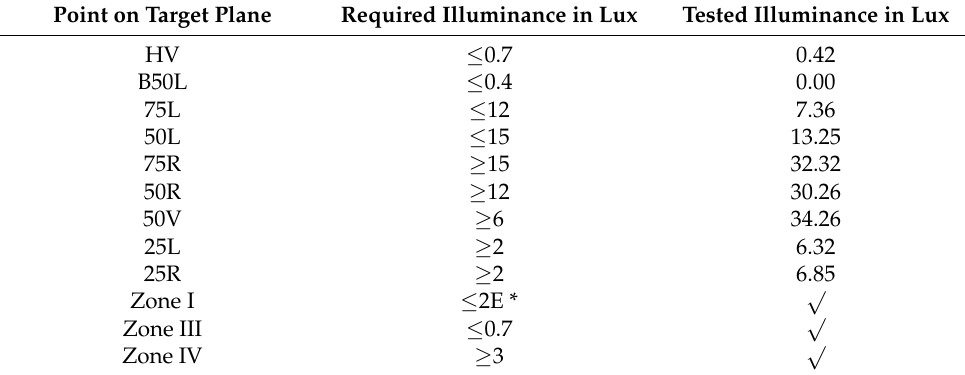
Table 3. Tested illuminance values of low beam on the target plane.